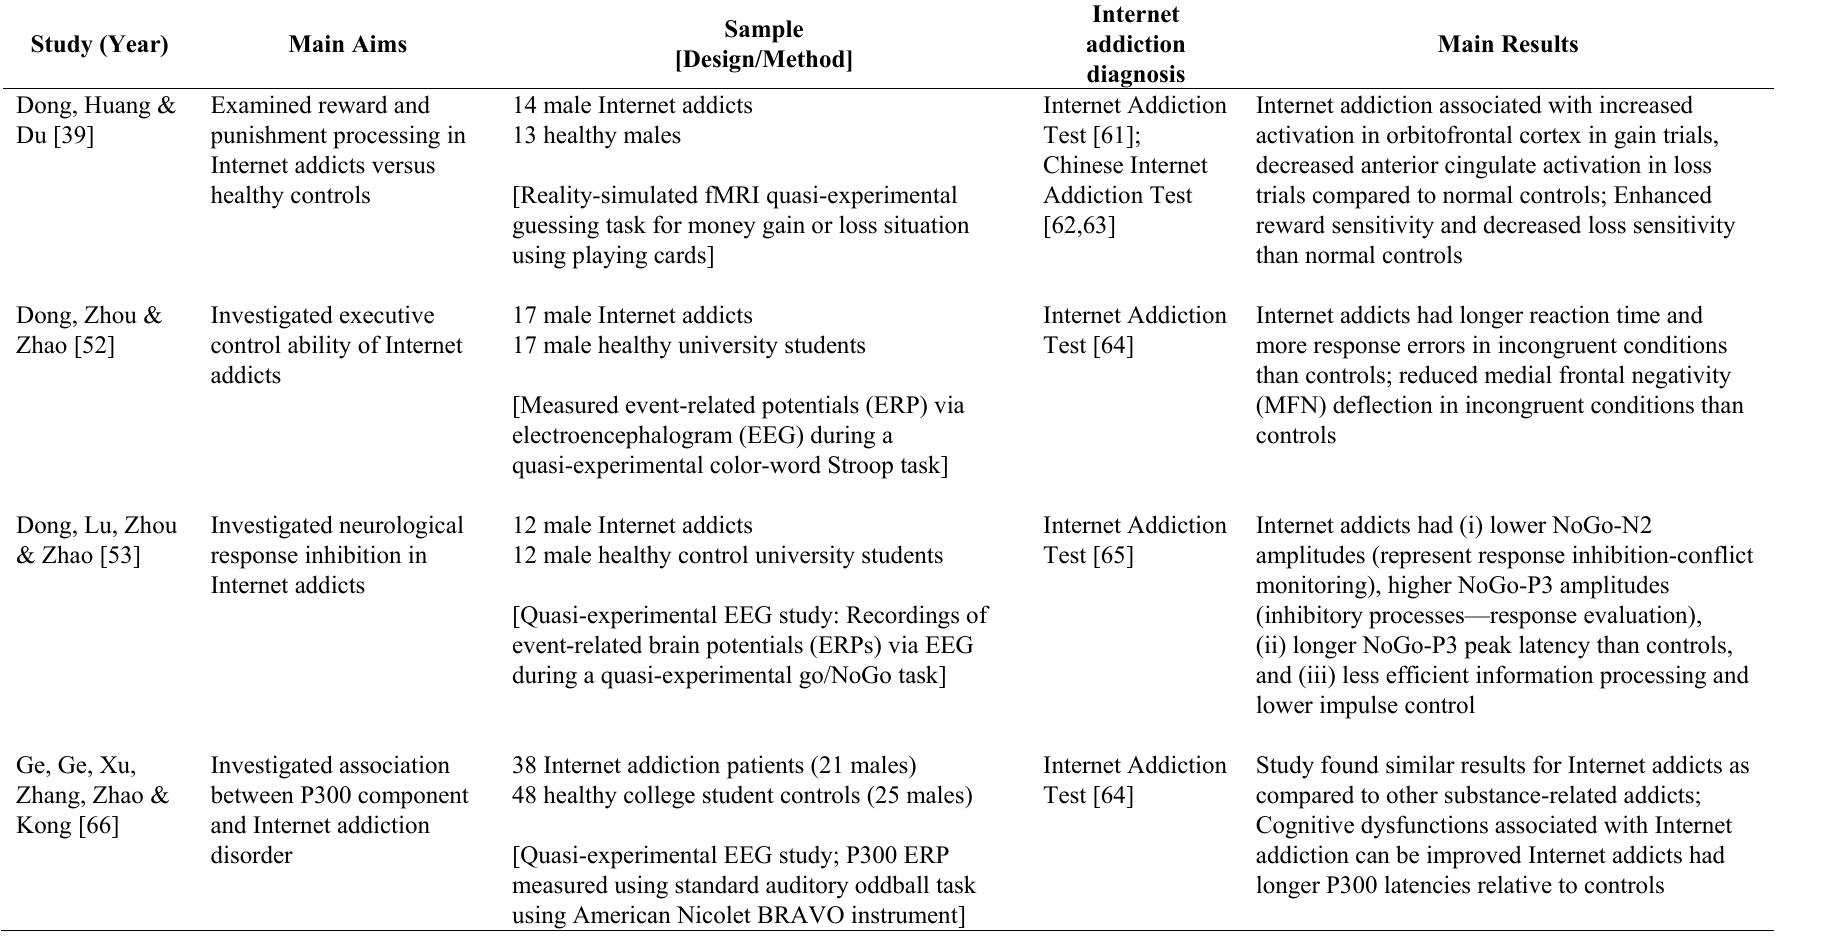
Table 1. Included